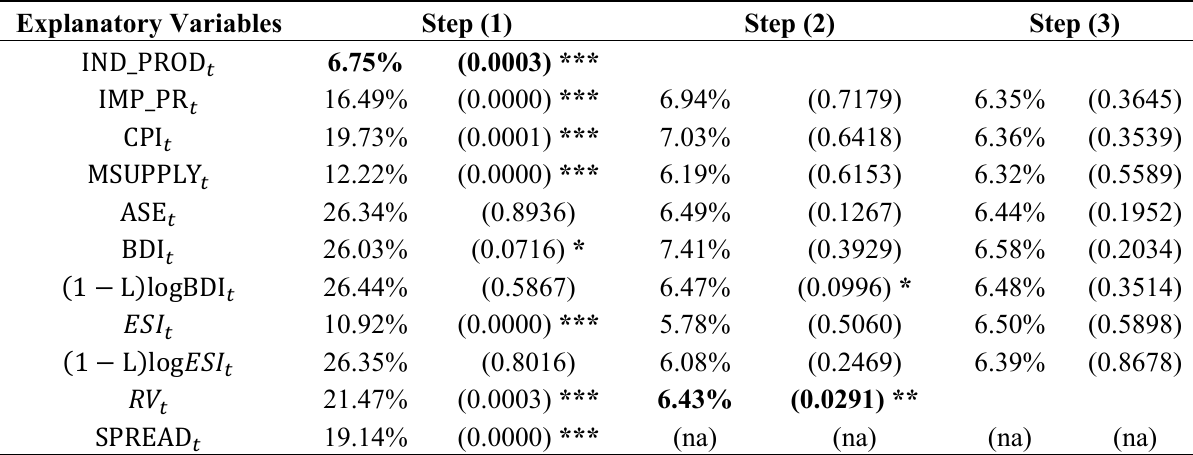
) , where (cid:2180) = 1) = Φ((cid:2236)(cid:2180) (cid:2930) (cid:3047) , IMP_PR , CPI , MSUPPLY (cid:3047) (cid:3047) (cid:3047)